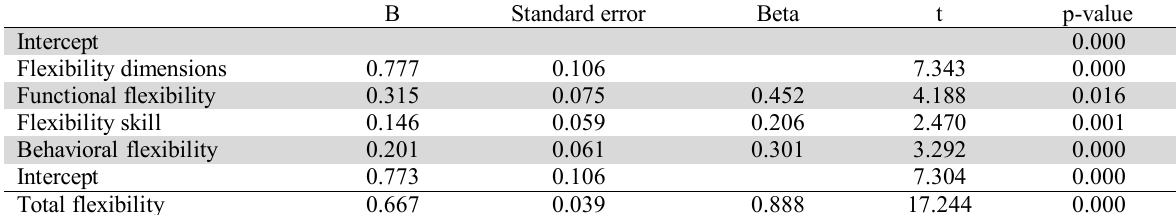
Regression coefficients of flexibility and its dimensions with human resource development B Standard error Beta t p-value Intercept 0.000 Flexibility dimensions 0.777 Functional flexibility Flexibility skill Behavioral flexibility